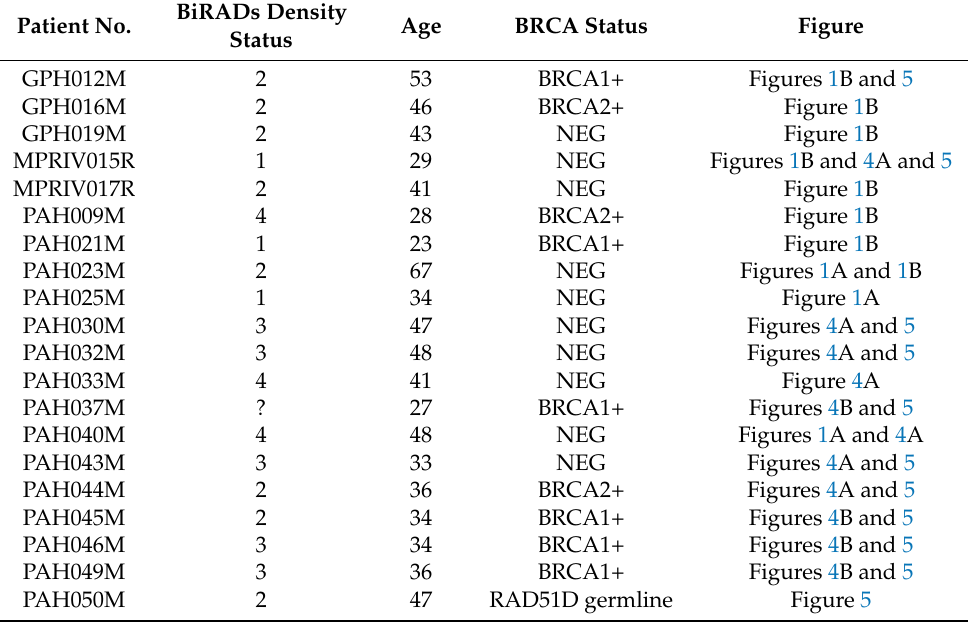
Table 1. Demographic characteristics of study participants ( n =